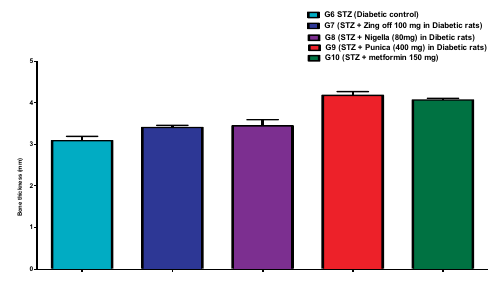
Fig. 2. Comparison of the bone thickness (mm) in different studied